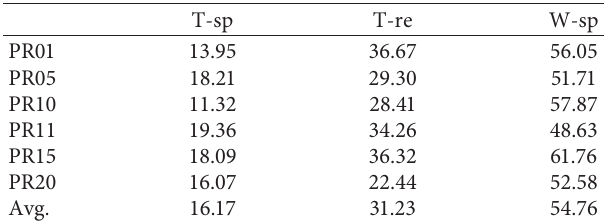
Table 4: Comparisons of the RPI values for different search strategies.